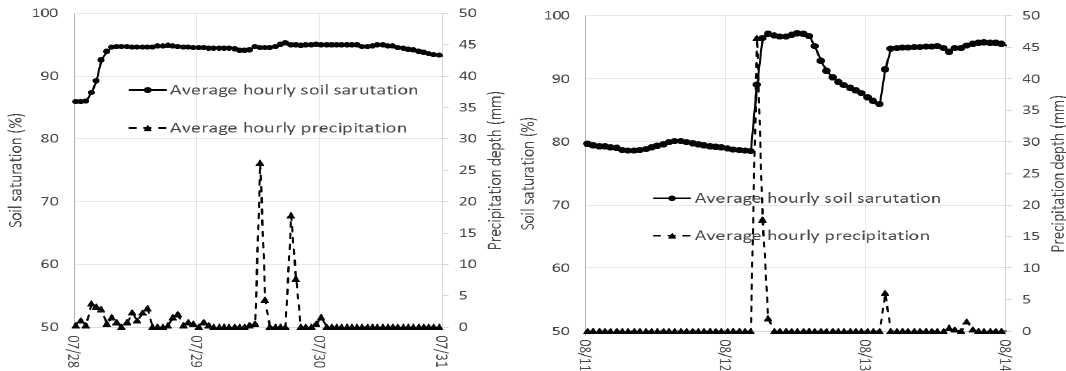
Fig. 5 Soil saturation and precipitation depth during the events on: (a) July 28 and 29; (b) August